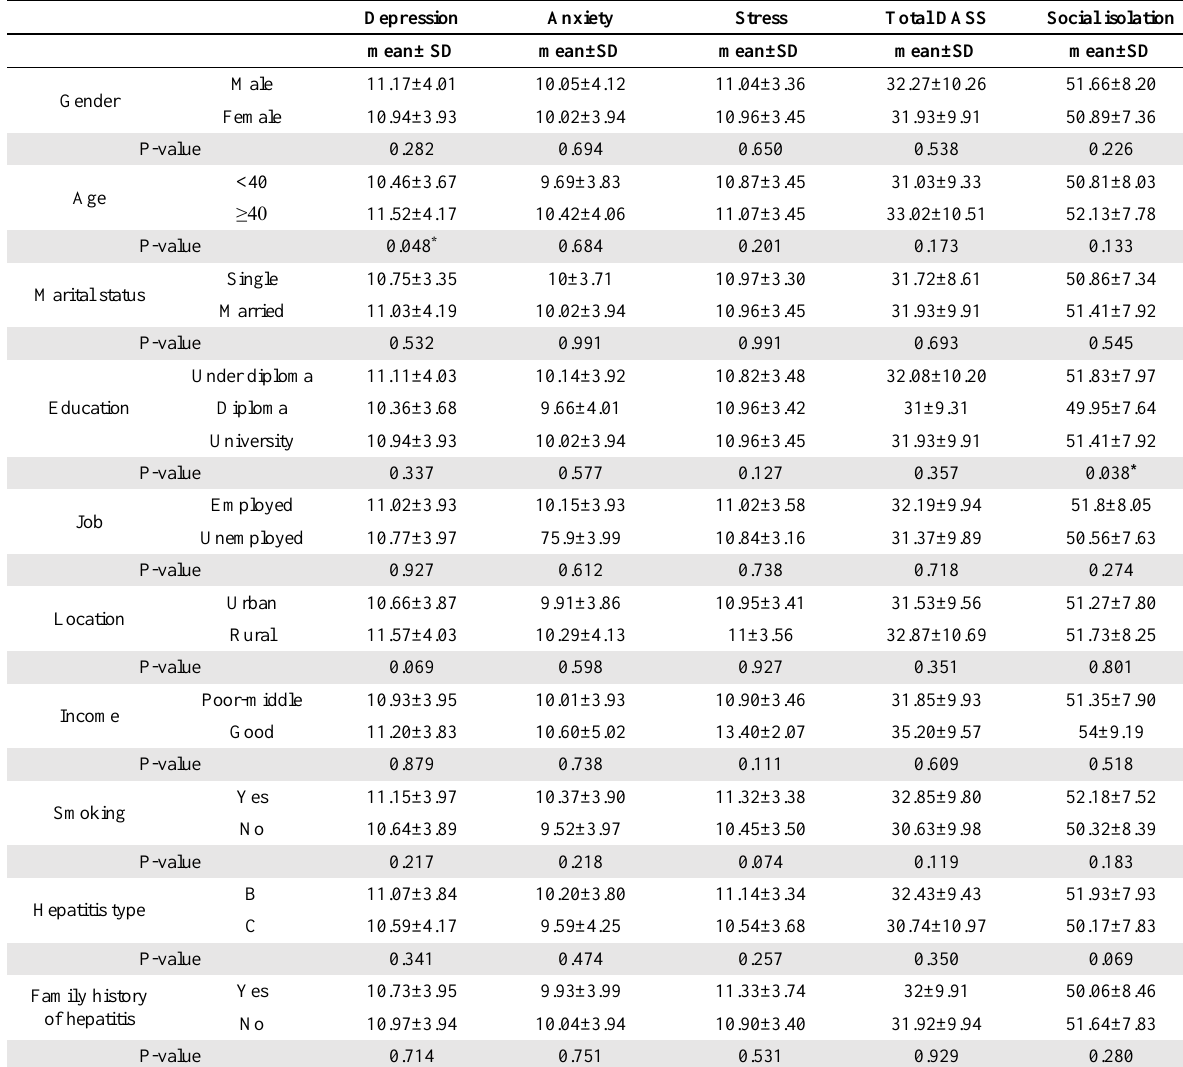
Table 4. Comparison mean of depression, anxiety, stress, and social isolation in terms of demographic